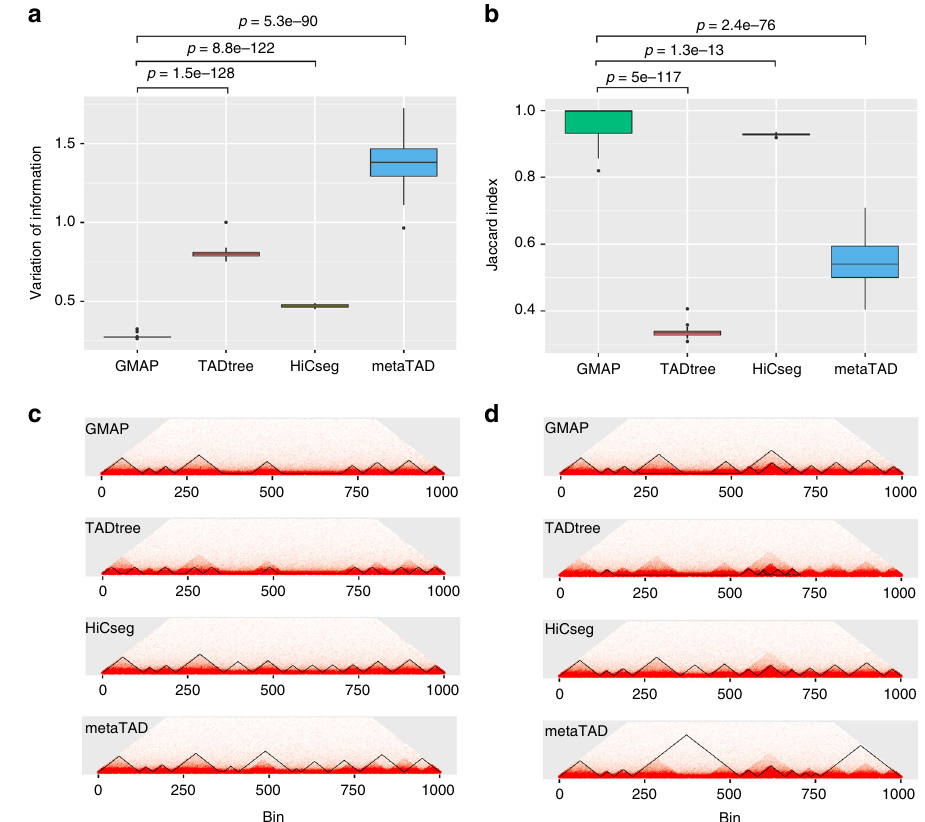
Fig. 2 Performance comparison using simulated data. Hi-C contact count matrices were simulated using Poisson distribution. a Overall similarity between predicted and true domains measured using the Variation of Information ( VI ) index. b Overall similarity between predicted and true domains measured using the Jaccard Index. Shown are boxplots of VI and Jaccard indices over 100 simulations. The whiskers represent the most extreme data point which is no more than 1.5 times the interquartile range. Paired t -test was used to compare the performance metrics (VI or Jaccard index) for different methods. P -values are based on paired t -test. c An example of called TADs by different methods using simulated Hi-C data without embedded sub-TADs. Called domains are outlined by solid black lines . d An example of called TADs by different methods using simulated Hi-C data with embedded TADs